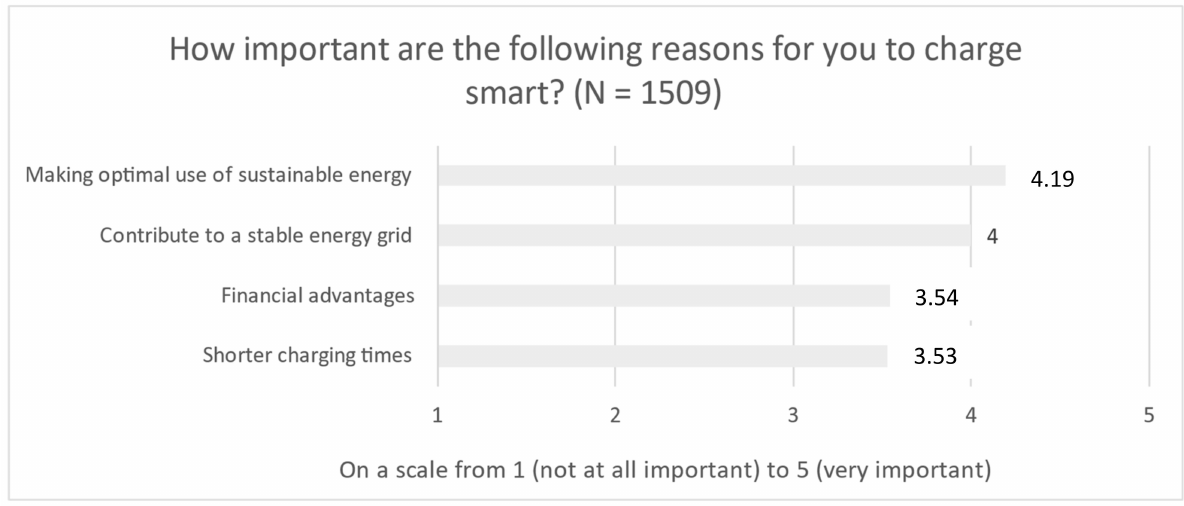
Figure 3. Wants of EV drivers for smart